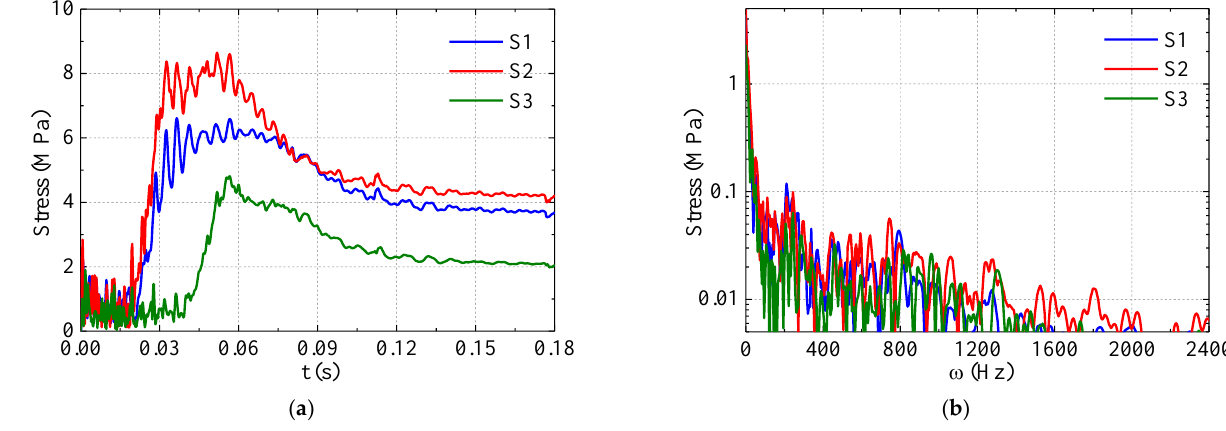
Figure 21. Structural stress at points S1 – 3 (Case 4): ( a ) time series; ( b ) frequency spectra.